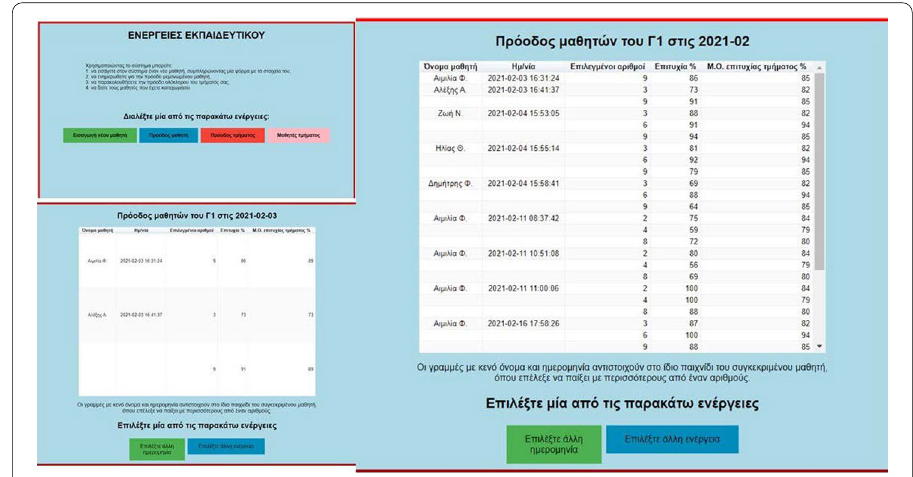
Fig. 7 Social opening of MG (teacher aspect